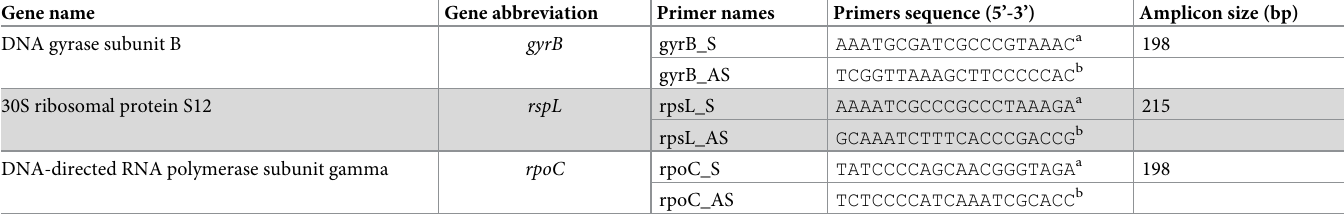
Table 2. Primer pairs tested for the three Planktothrix agardhii PCC 7805 genes in qPCR realized with the RNA obtained from the RNA extraction protocol devel- oped in this